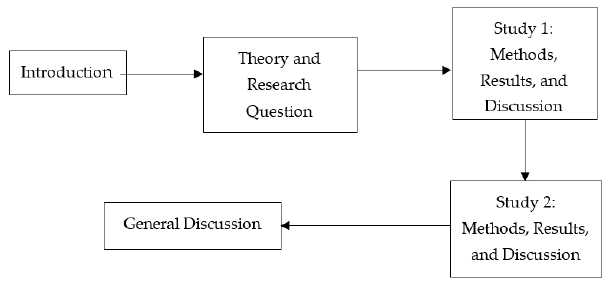
Figure 1. A Flowchart of the Research Process.